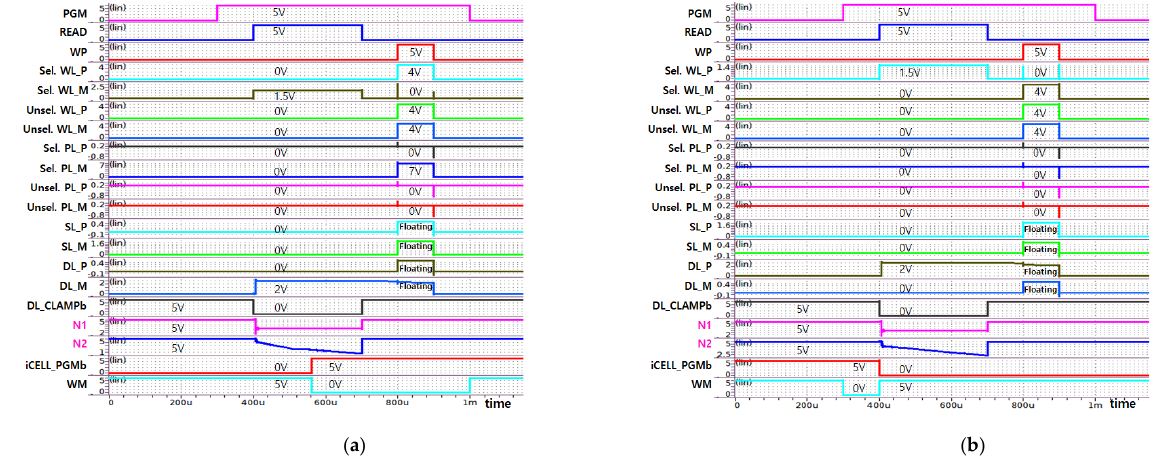
Figure 17. Simulation results for the program mode according to eFlash cell currents: ( a ) I cell = 49 nA; ( b ) I cell = 49.5 nA